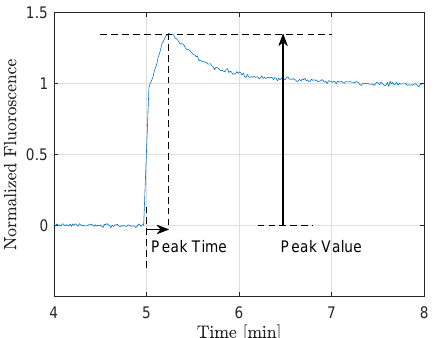
Figure 2. Arrows showing the peak time and the peak value. The peak value is the maximal value of the normalized fluorescence. The peak time is the time evolved from the time the excitation light is added until the peak value is